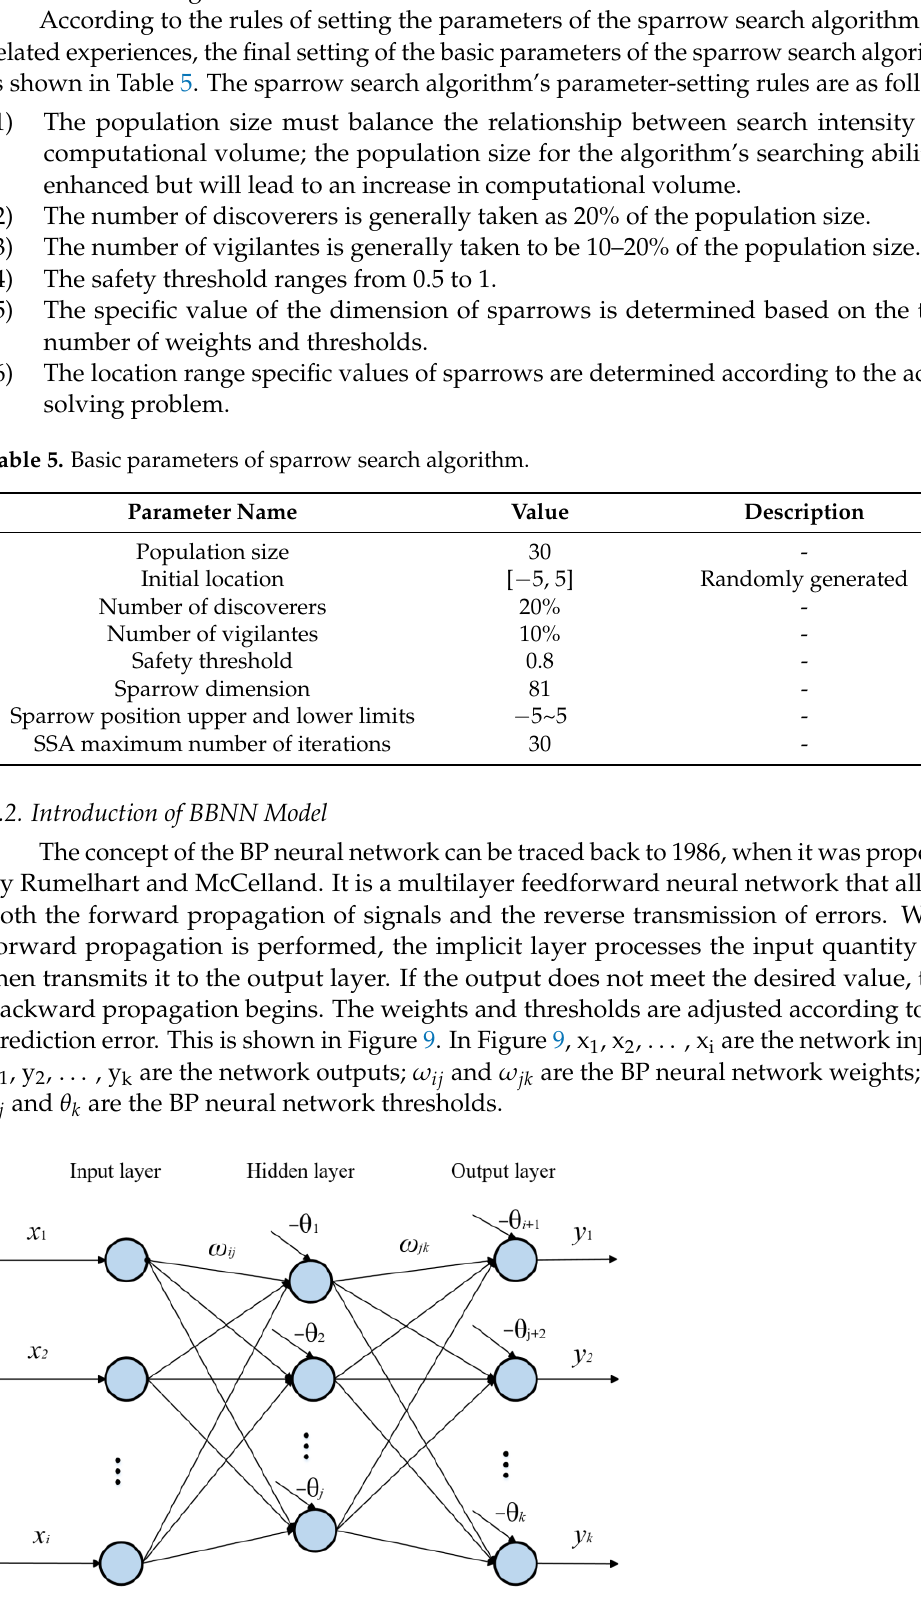
Figure 9. The topology structure diagram of BPNN.